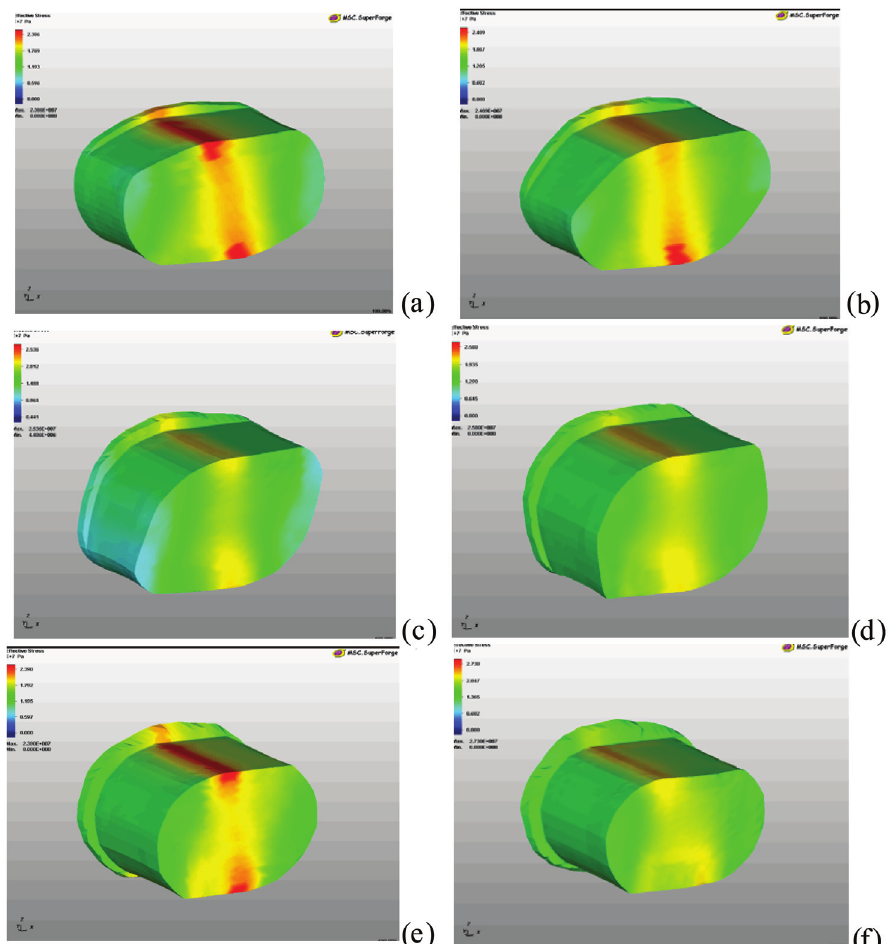
Figure 6: Picture of deformation intensity distribution in workpiece at a broach in flat baizes with single reduction of 80% and with angles of rotation 30° (a), 60° (b), 90° (c), 120° (d), 150° (e) and 180° (f), t ¼ 1,250°C.